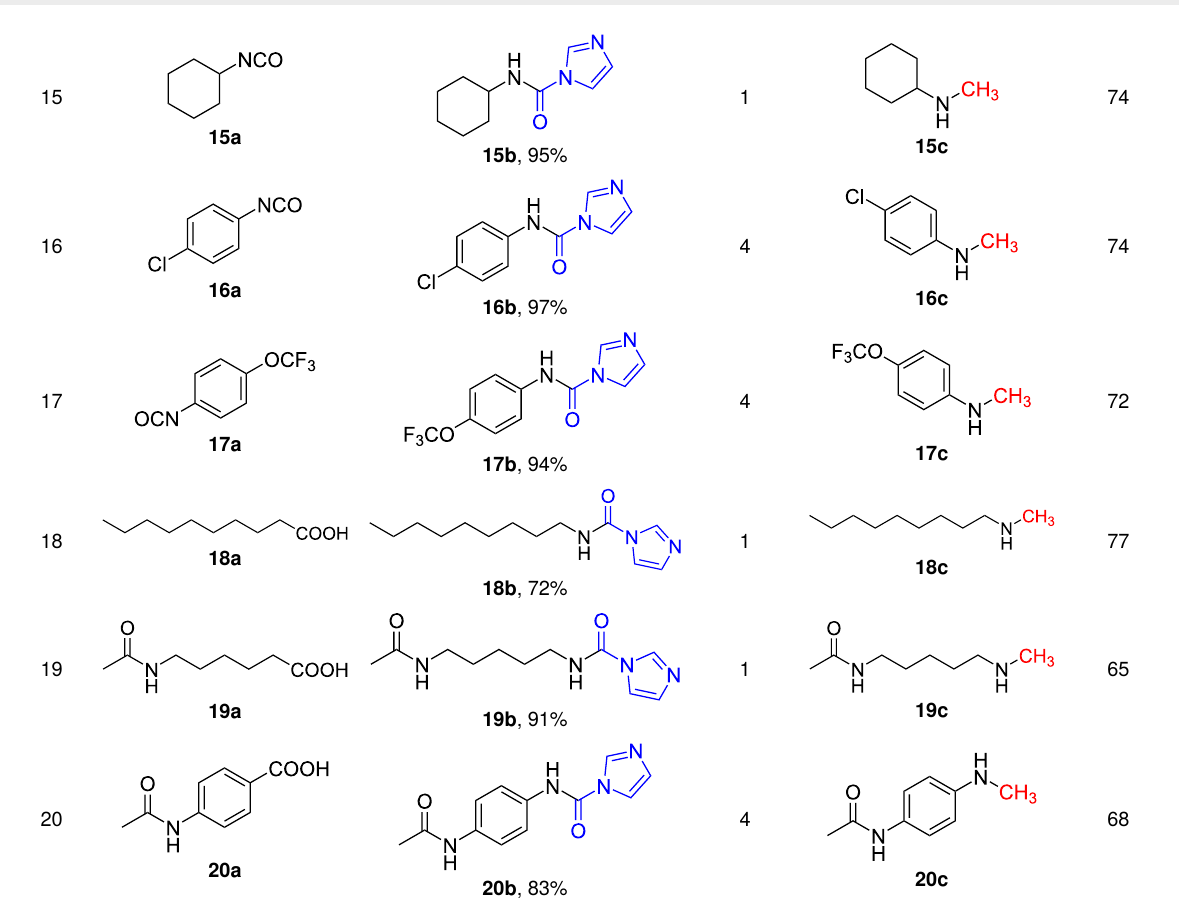
Table 2: Synthesis of monomethylamines from amines, carboxylic acids and isocyanates. a